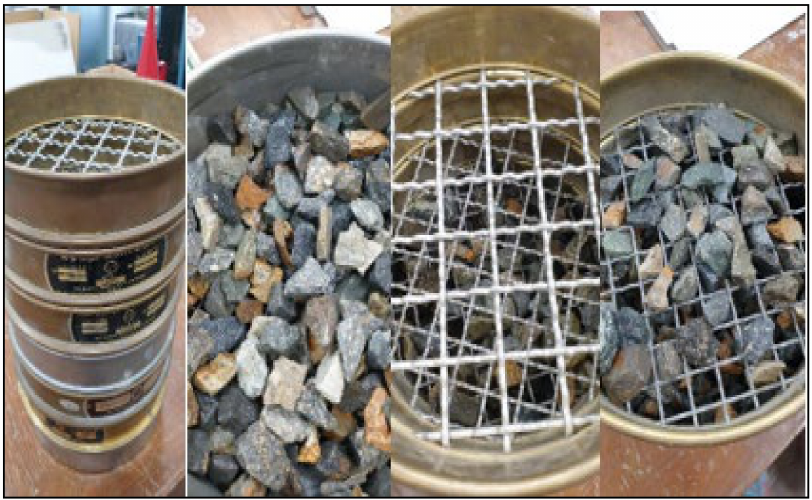
Figure 2. Sieve analysis for the